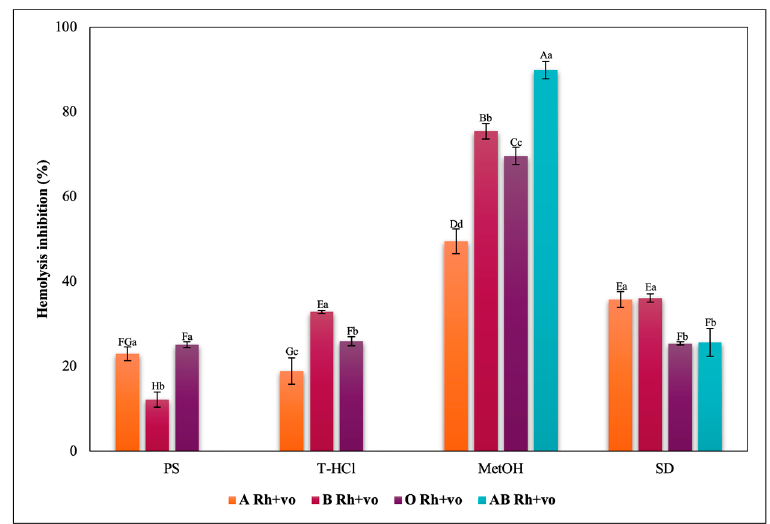
Figure 17. Inhibitory effect of heat-induced hemolysis of P. cruentum extracts on human erythrocytes with different ABO blood groups. Different letters represent significant differences in the means between treatments and groups ( p ≤ 0.001). Capital letters represent a two-way ANOVA. Lowercase letters represent a univariate ANOVA between the extracts. PS, extract of physiological solution; T-HCl, 0.5 M Tris-HCl extract; MetOH, 99% methanol extract; SD, sodium diclofenac.